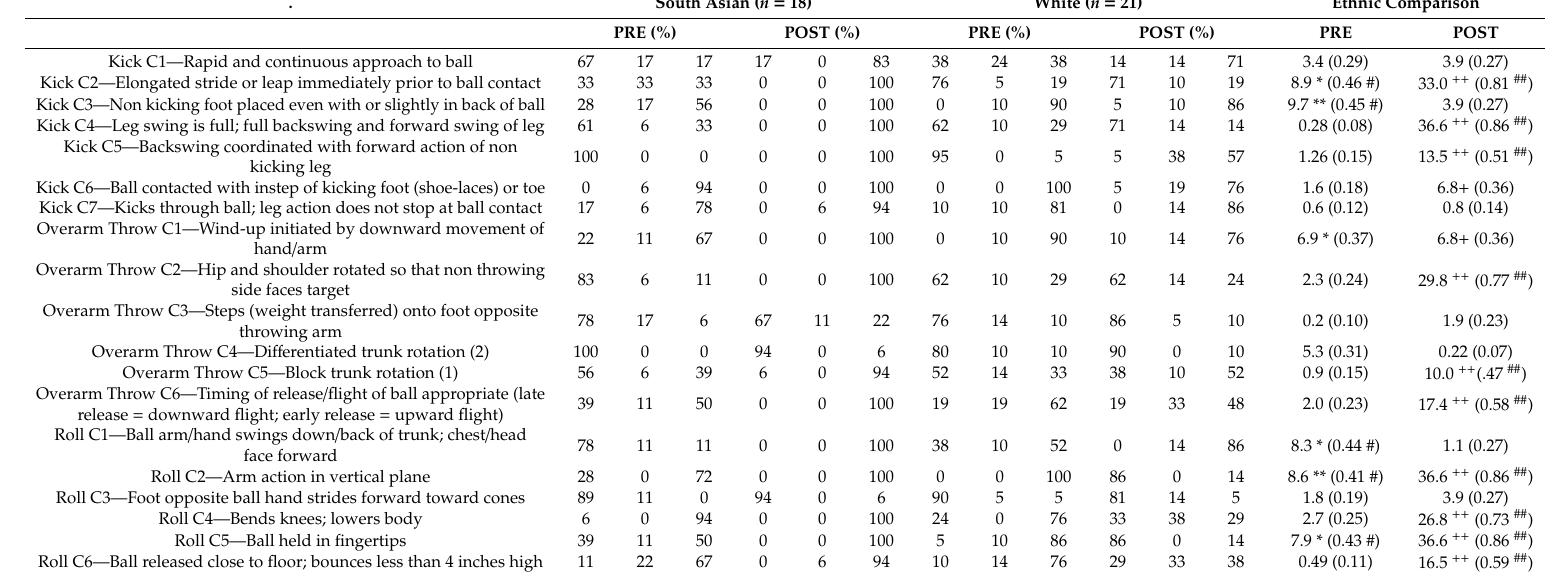
Roll C1—Ball arm / hand swings down / back of trunk; chest / head face forward Roll C2—Arm action in vertical